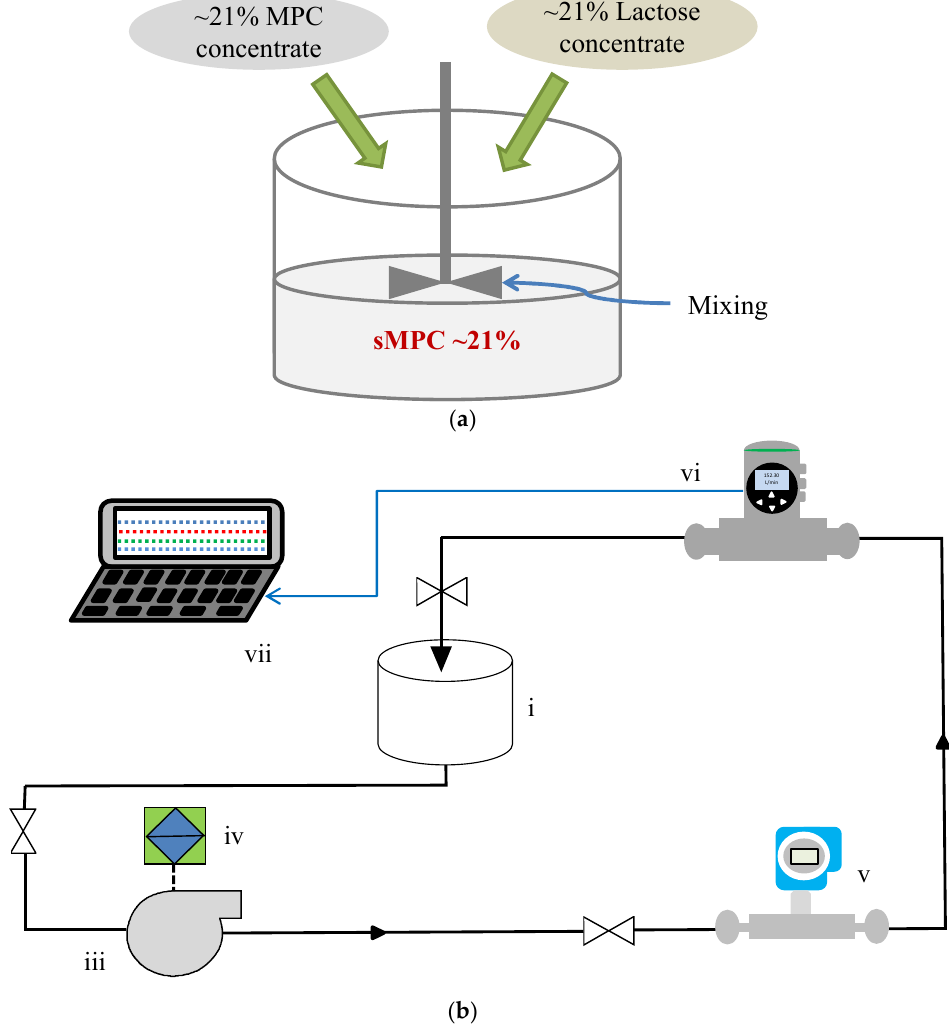
Figure 2. ( a ) Preparation of standardised milk protein concentrate (sMPC) with addition of lactose concentrate. ( b ) Schematic of an inline acoustic flowmeter in a laboratory scale skid. (i) Five litre tank; (ii) globe valve; (iii) centrifugal pump; (iv) variable speed drive; (v) inline Coriolis flowmeter; (vi) inline acoustic flowmeter; (vii) laptop.